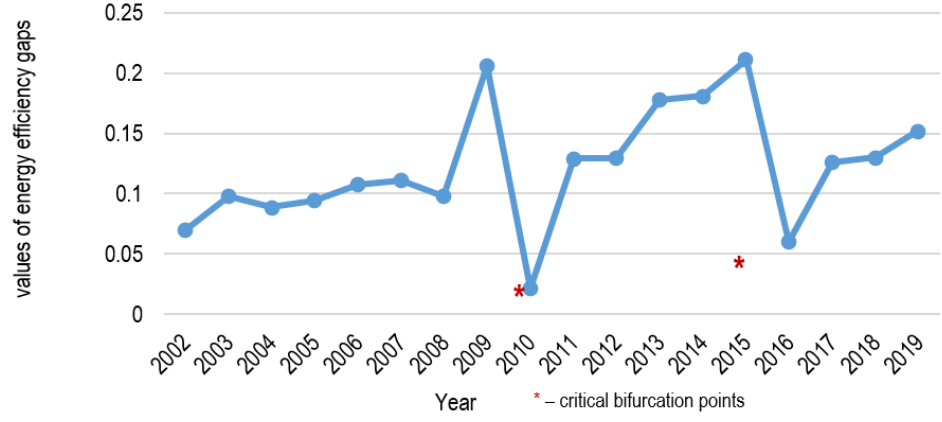
Figure 2. Graphical interpretation of the assessment results of the energy efficiency gaps in Ukraine in 2002–2019. Source: compiled by the author.